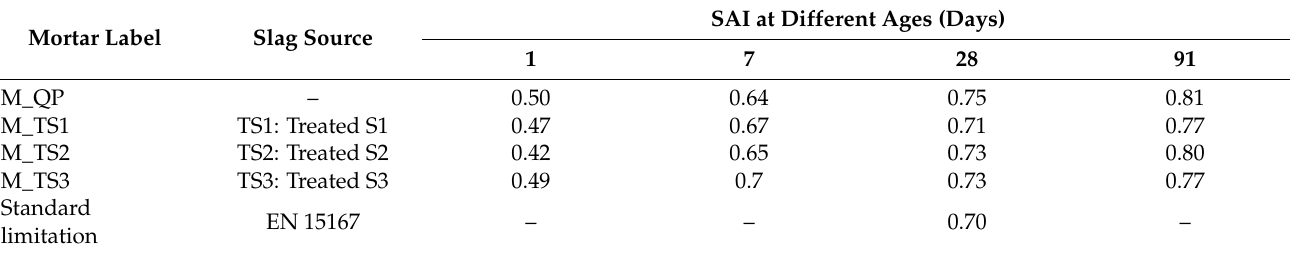
Figure 11. Compressive and flexural strength results of mortar mixtures up to the age of 91 days. ( a ) compressive strength, ( b ) flexural strength. Table 10. Strength activity indexes (SAIs) of the slags at different